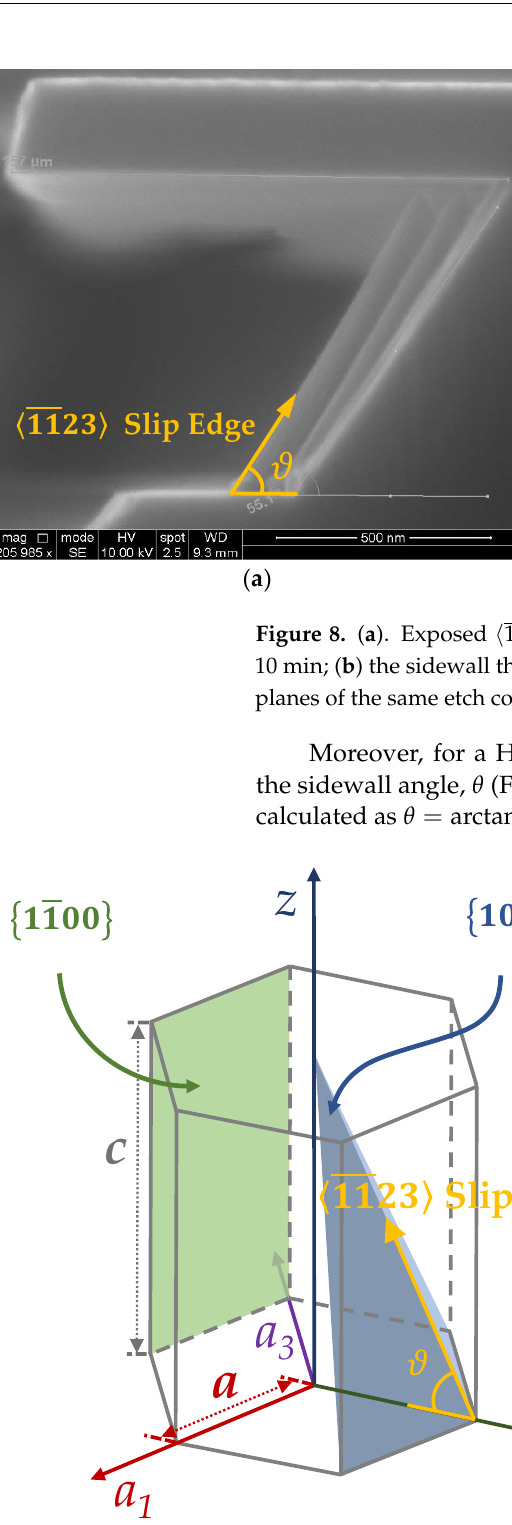
Figure 9. Crystal planes in Al 1 − x Sc x N HCP lattice. Using the c / a data from the work presented by Österlund et al. [45], and considering the isotropic etching of the {1011} plane, the theoretical sidewall angle φ can be plotted against the experimental value (Figure 10).